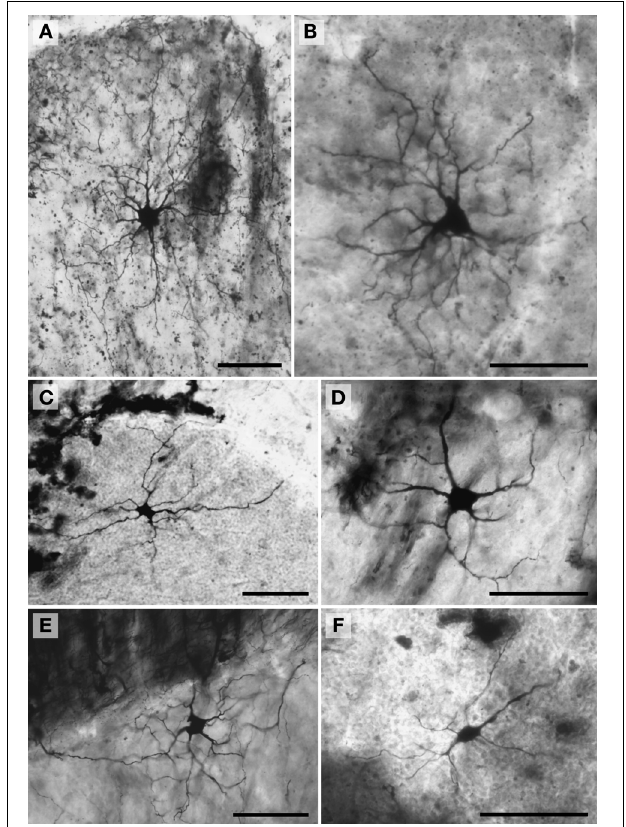
FIGURE 5 | Photomicrographs of Golgi-stained Lugaro neurons. ( A , see also Figure 8J ) and ( C , see also Figure 8L ) African elephant; in these two neurons, note the bouquet shaped dendritic arbor in (A) and the more solitary, unbranched dendritic arbor in (C) , with both descending to the underlying white matter. The (B) humpback whale (see also Figure 10L ) and (D) chimpanzee also have predominantly unbranched dendritic trees. ML, molecular layer; PCL, Purkinje cell layer; GCL, granule cell layer. Scale bars: 100 μ m.